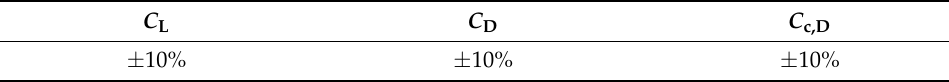
Table 5. Uncertain coefficients in Monte Carlo simulation.